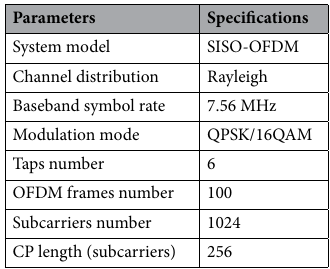
Table 1. Simulation parameters of the OFDM system.